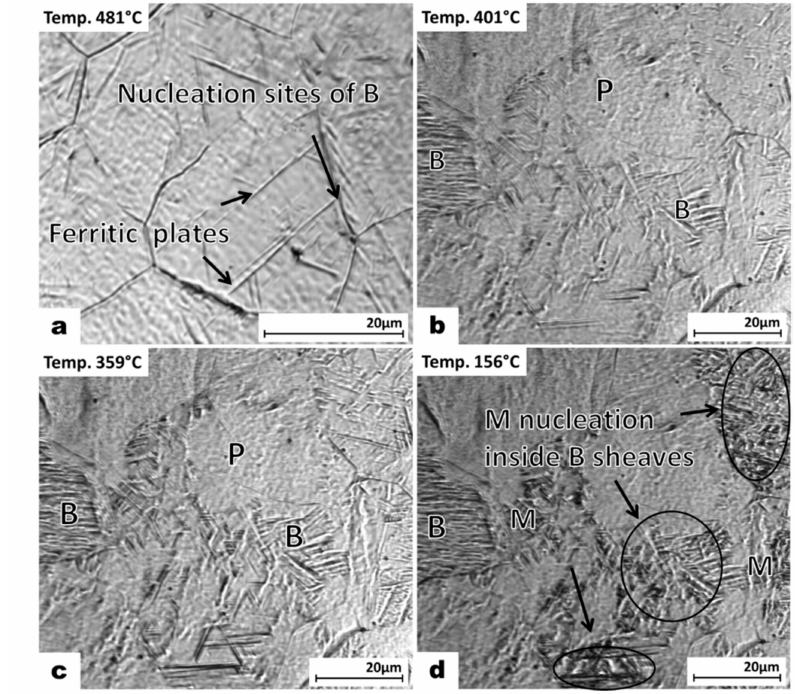
Figure 6. Formation of bainite and martensite at 6 ◦ C / s cooling rate; From ( a – d ) successively. P: Pearlite, B: Bainite, M: